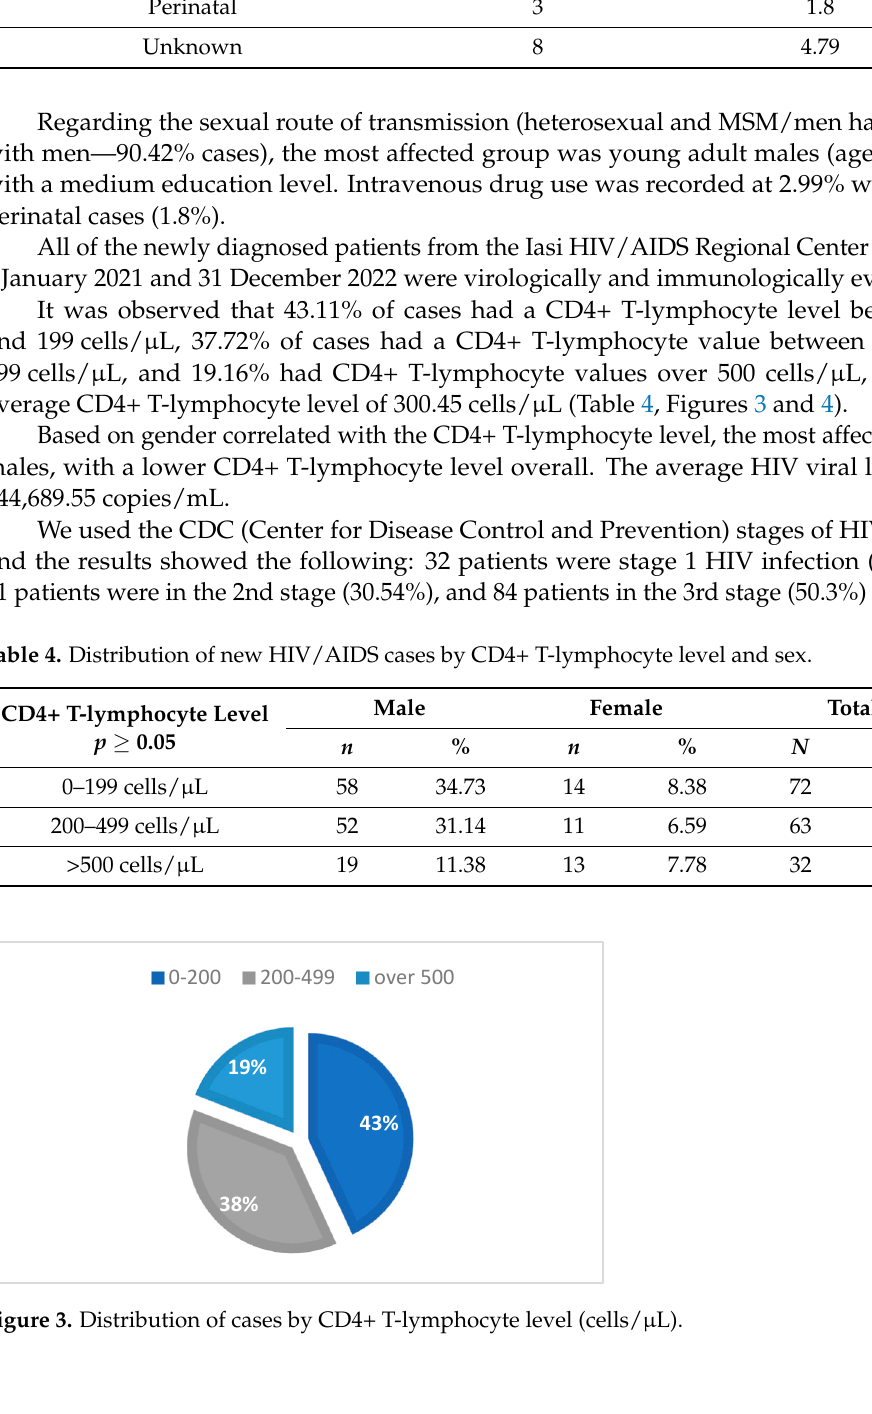
Figure 4. Distribution of new HIV/AIDS cases by CD4+ T-lymphocyte level and HIV viral load. We used the CDC (Center for Disease Control and Prevention) stages of HIV/AIDS, and the results showed the following: 32 patients were stage 1 HIV infection (19.16%), 51 patients were in the 2nd stage (30.54%), and 84 patients in the 3rd stage (50.3%) (Table 5). Table 5. Distribution of study cases by CDC, HIV/AIDS classification. Classification of the Studied Cases